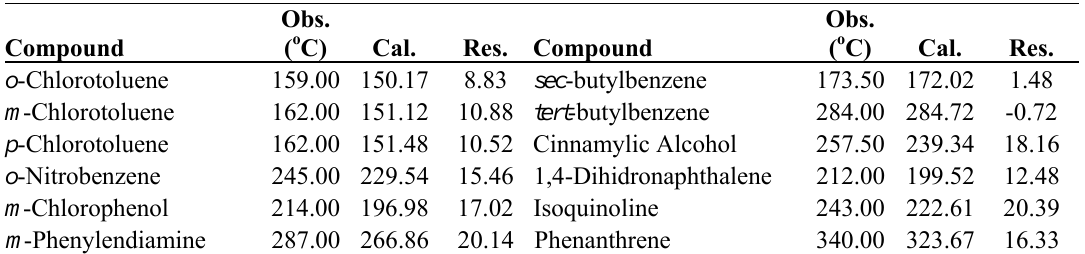
Table 15. Experimental and Calculated Values of the Bp of Molecules, Included in the Test Set, that Contain Aromatic Cycles in their Molecular Structure as Well as Residual of